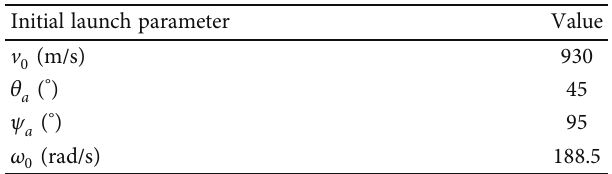
Figure 3: The structure of IPSO-ELM-AdaBoost. Table 3: Initial launch parameters of